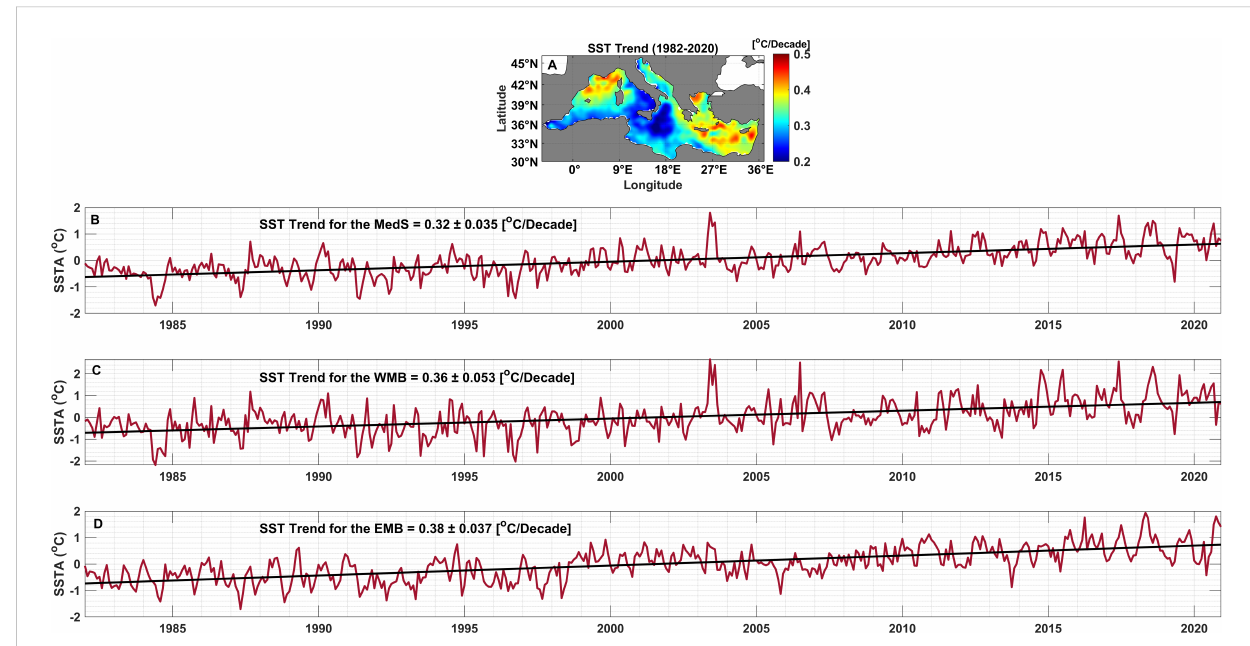
FIGURE 2 The spatial and temporal trend of Mediterranean SST from 1982 to 2020. (A) The spatial trend map of deseasonalized SST in °C/decade and the temporal trend of monthly averaged SSTA for the whole Mediterranean Sea (B) , WMB (C) , and EMB (D) . The SSTA trend is shown by the solid black